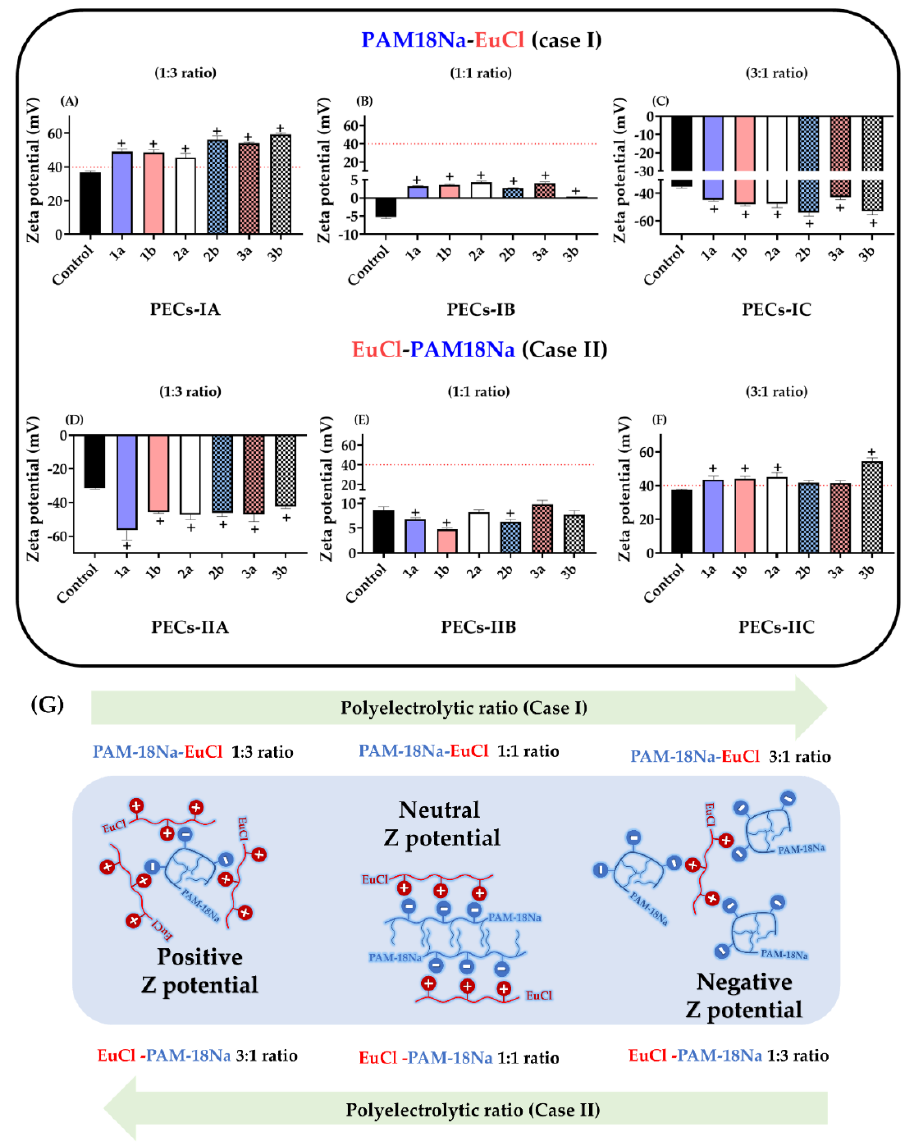
Figure 4. Characterization of zeta potential for ampicillin-loaded PECs. ( A ) PAM-18Na-EuCl 1:3 ratio. ( B ) PAM-18Na-EuCl 1:1 ratio. ( C ) PAM-18Na-EuCl 3:1 ratio. ( D ) EuCl-PAM-18Na 1:3 ratio. ( E ) EuCl-PAM-18Na 1:1 ratio. ( F ) EuCl-PAM-18Na 3:1 ratio. ( G ) Scheme of the formation of the PECs interfaces